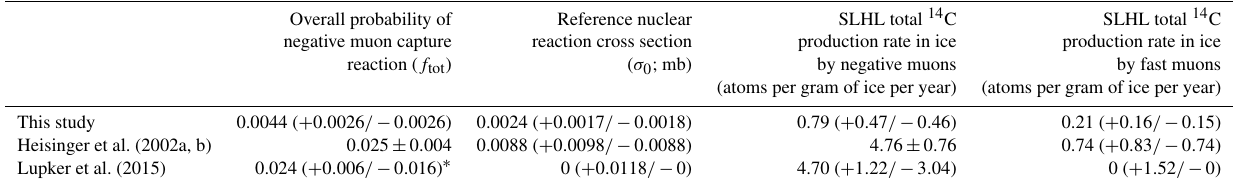
Table 2. Probability of the 14 C production from stopped negative muons ( f tot ), reference nuclear reaction cross section for production via fast muon interactions ( σ 0 ), and total 14 C production rates in ice at the surface from the two muon reactions rescaled to SLHL (sea level high latitude), using the Lifton et al. (2014) LSDn scaling. All errors shown represent the 95% confidence interval. Overall probability